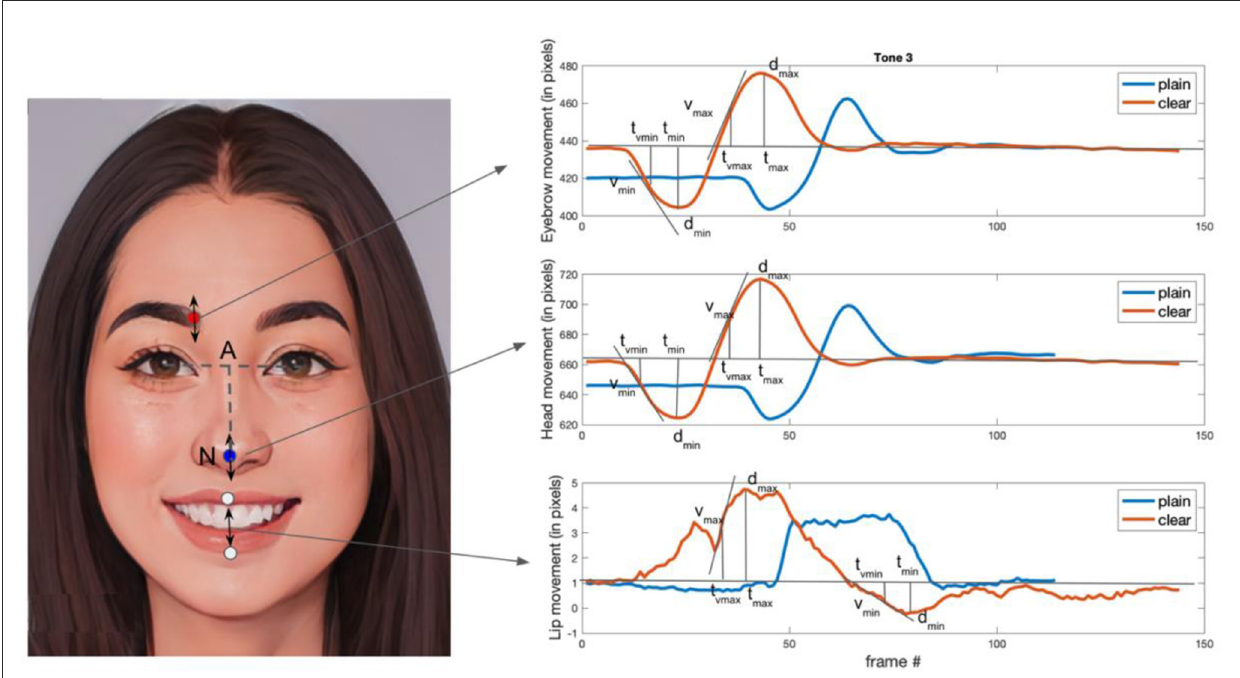
FIGURE1 The left-side image shows the landmark points (keypoints) at which the trajectory of the vertical movement is measured. A total of four keypoints are selected corresponding to the nose tip (proxy for the head, blue), left eyebrow (red), and lips (white). The right-side plots show the head, eyebrow, and lip movement trajectories for a sample token comparing the clear and plain speech style. Normalization factor used in the analysis is the length of the line segment AN. D, distance; t, time; v, velocity; max, raising/opening; min, lowering/closing (The face is generated by AI.).